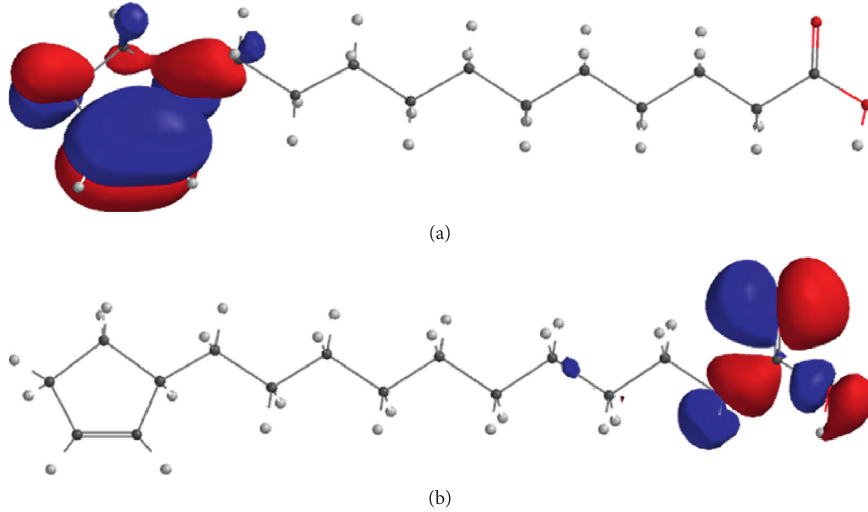
Figure 10: (a) HOMO and (b) HOMO { − 1} map of chaulmoogric acid.